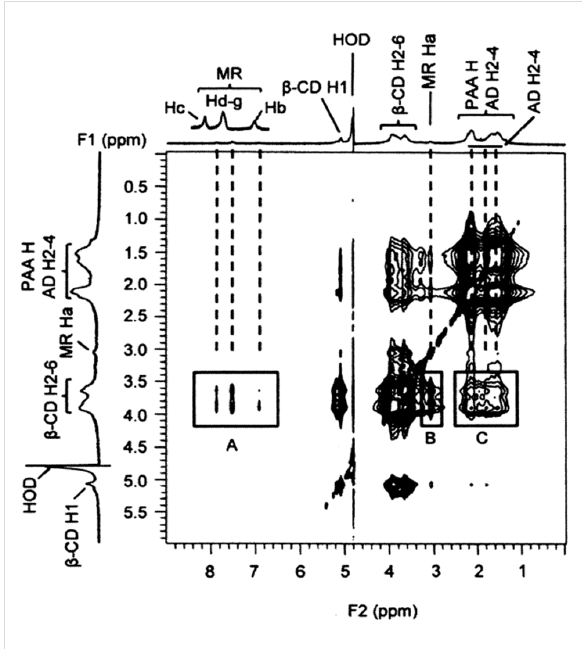
Figure 9: 2D NOESY 1 H NMR spectrum of MR ([MR] = 2.0 × 10 − 3 mol dm − 3 ) in solution with PAA β -CDen (0.78 wt %, [ β -CDen] = 3.6 × 10 − 3 mol dm − 3 ) and PAAADen (0.40 wt %, [ADen] = 1.2 × 10 − 3 mol dm − 3 ) in D 2 O Na 2 HPO 4 /KH 2 PO 4 buffer solution at pD 7.0 and I = 0.10 mol dm − 3 at 298.2 K. Cross-peaks in boxes A and B are attributed to dipolar interactions of the annular H3,5,6 protons of